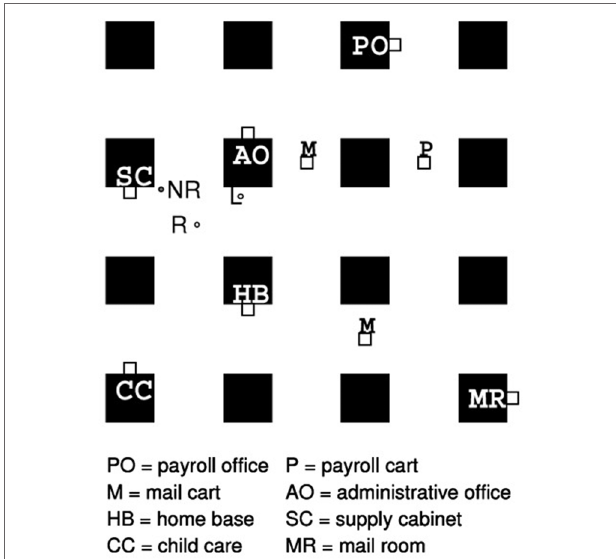
FIGURE 7 | Simulation in progress, screenshot . A map of the office environment, top, shows offices and obstacles (black squares), targets (white squares abutting offices), and three agents ( L , R , and NR ). Below the grid-world map is a list of target locations corresponding to agent